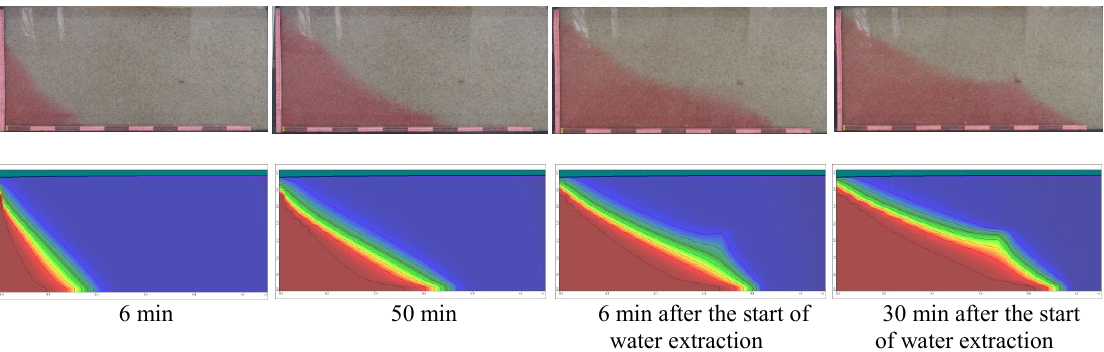
Fig. 2: Illustration of the whole process of saltwater invasion from beginning to the end in H2C2Q2 experiment